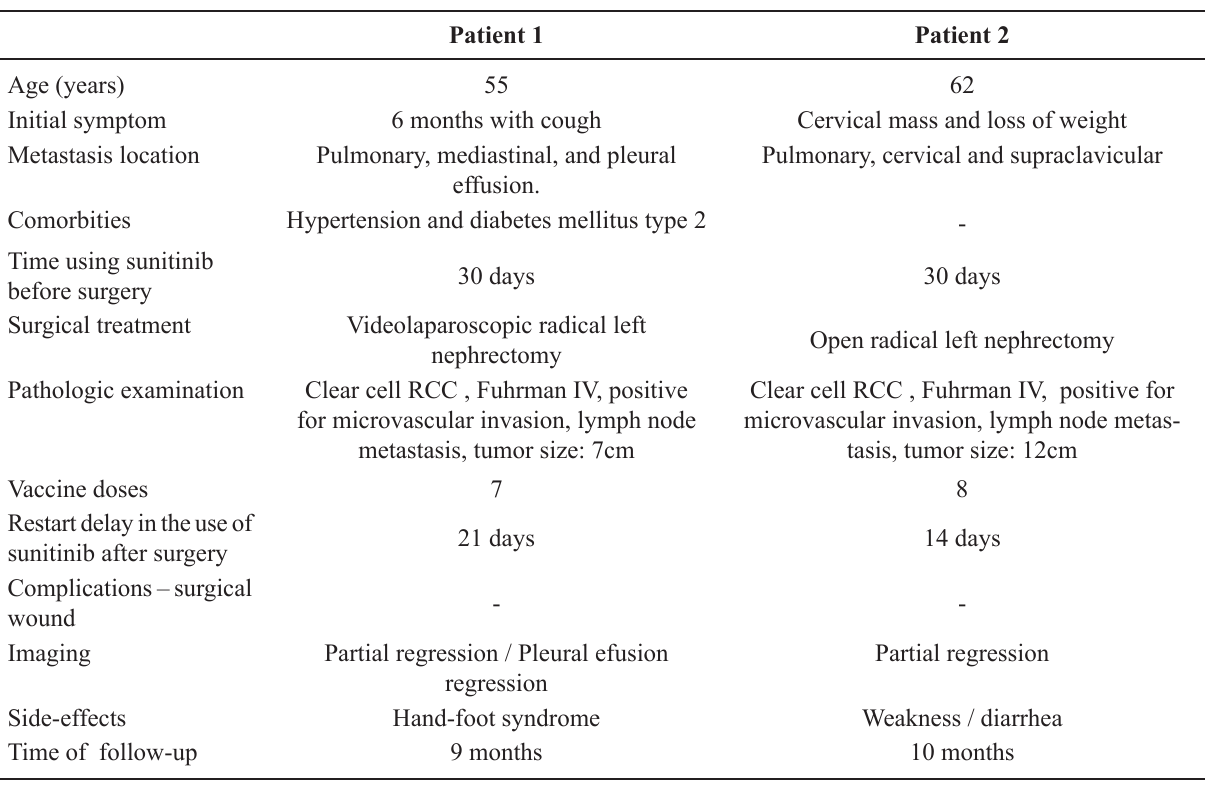
Table 1 – Patient’s characteristics, management and